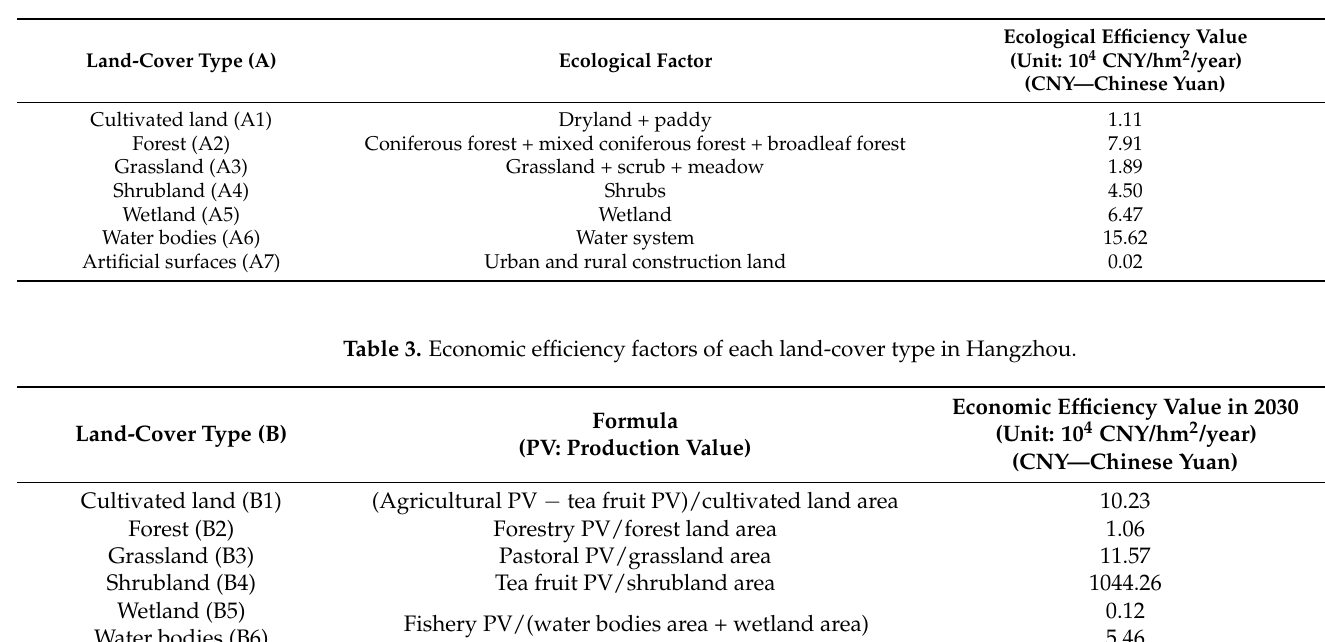
Table 2. Ecological efficiency factors of each land-cover type in Hangzhou.